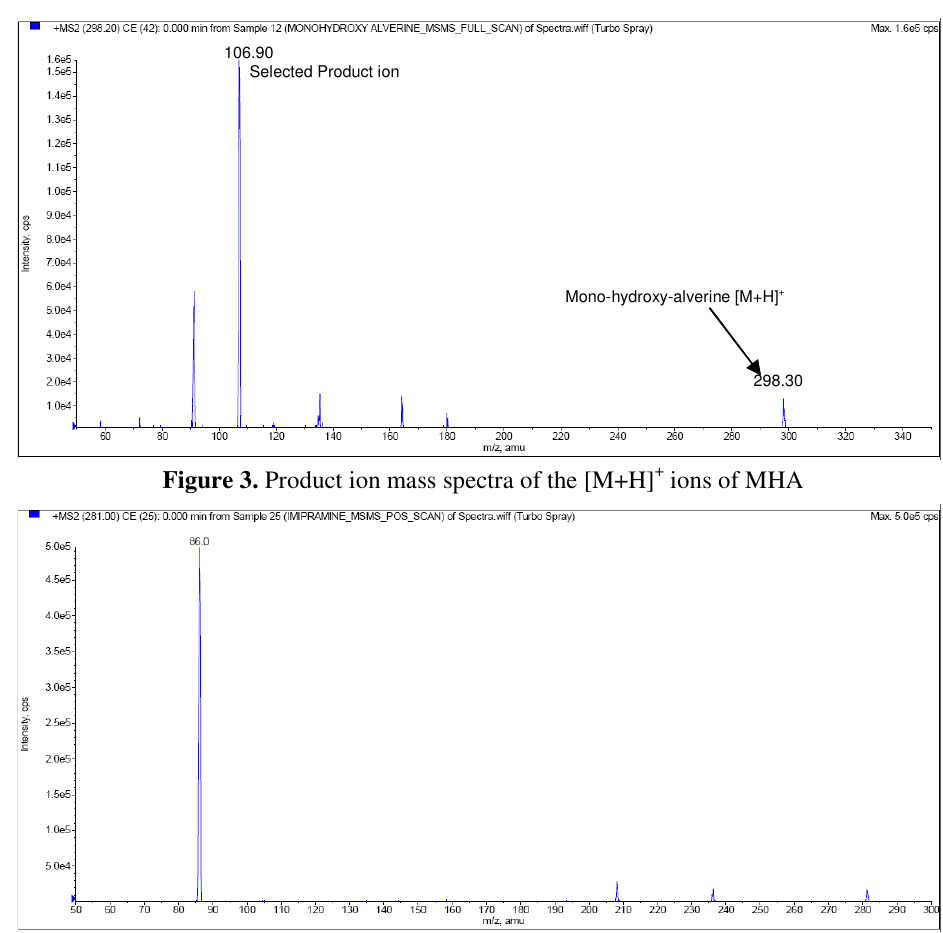
Figure 4. Product ion mass spectra of the [M+H] + ions of